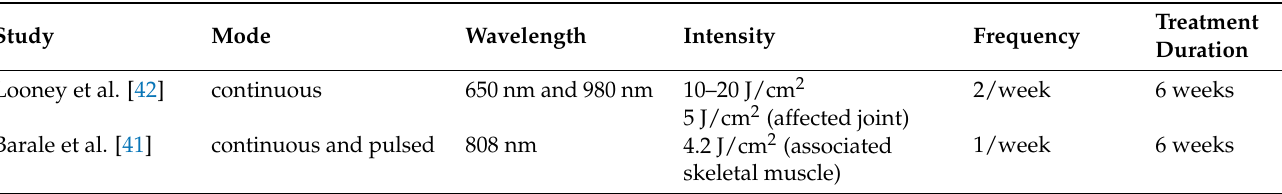
Table 1. Treatment parameters for OA in affected